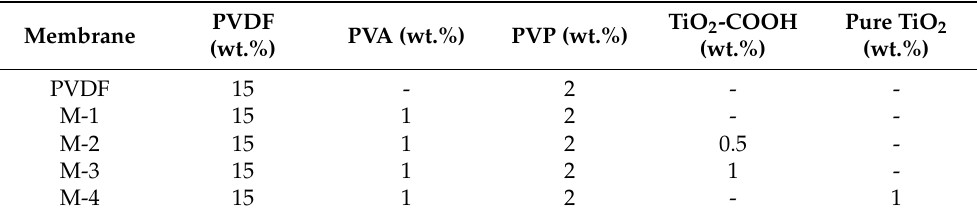
Table 3. Summary of the composition of membrane. Reprinted/Adapted with permission from ref. [35]. © 2015 Elsevier